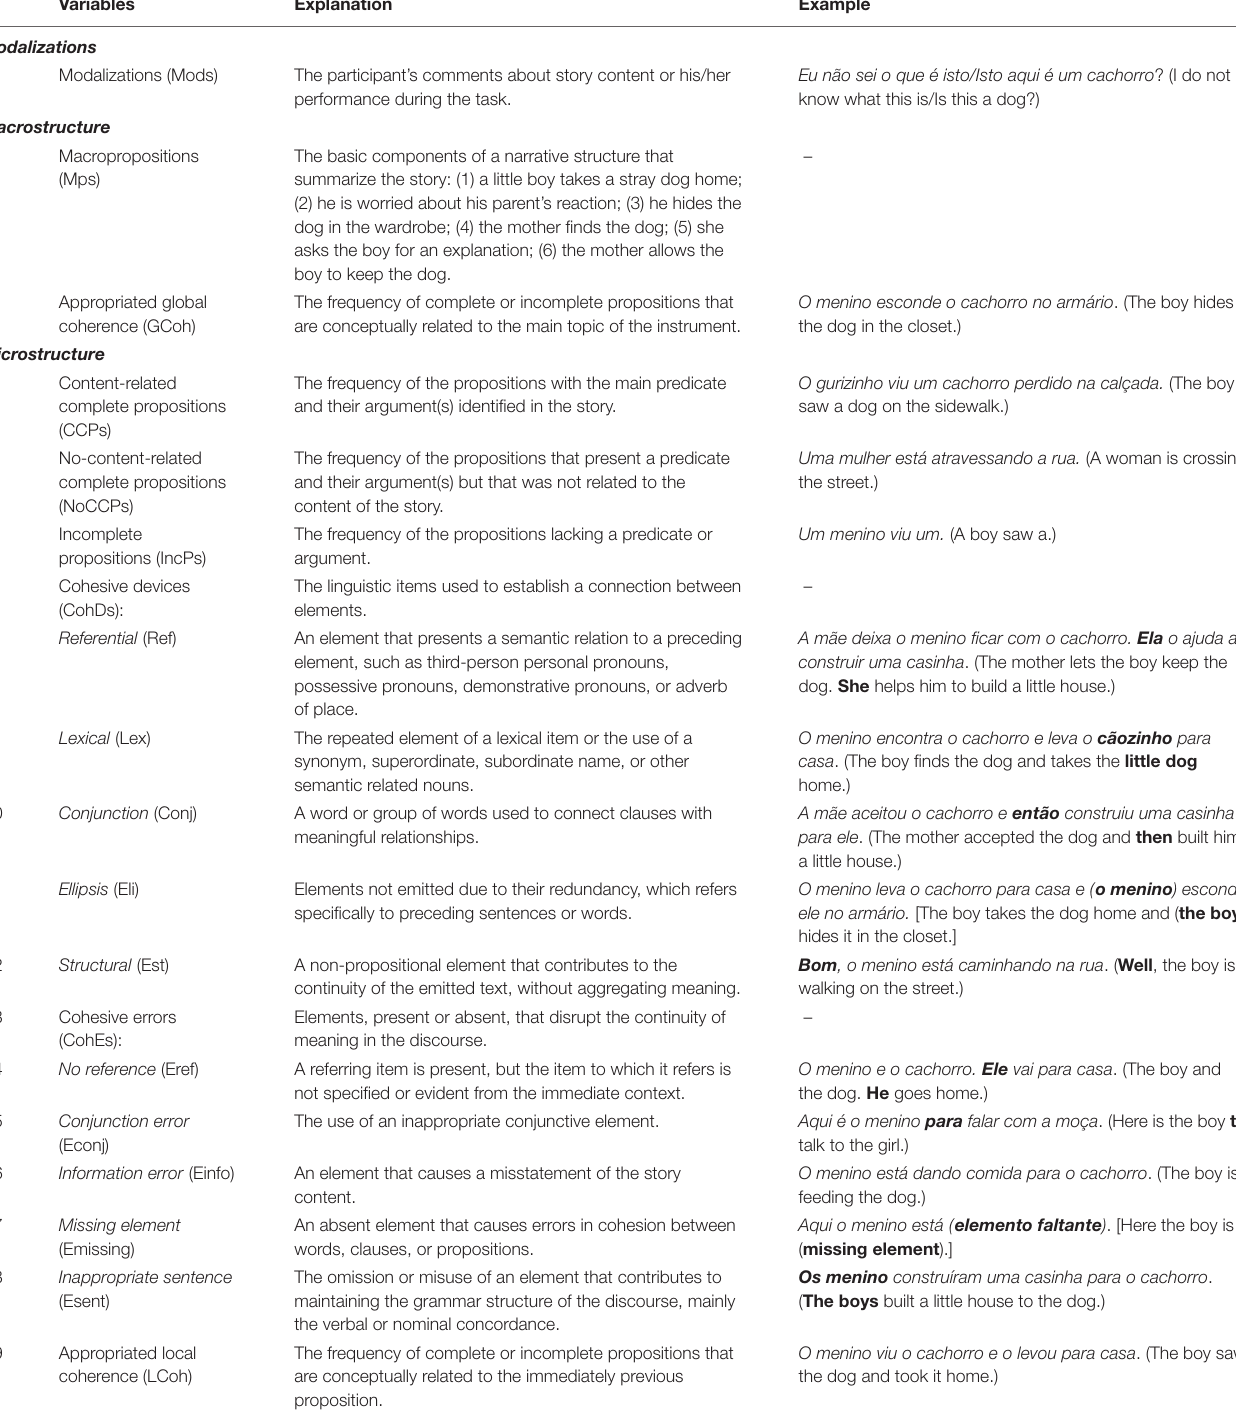
TABLE 2 | Linguistic variables used in the study, based on Lira et al. (2018). Variables Explanation